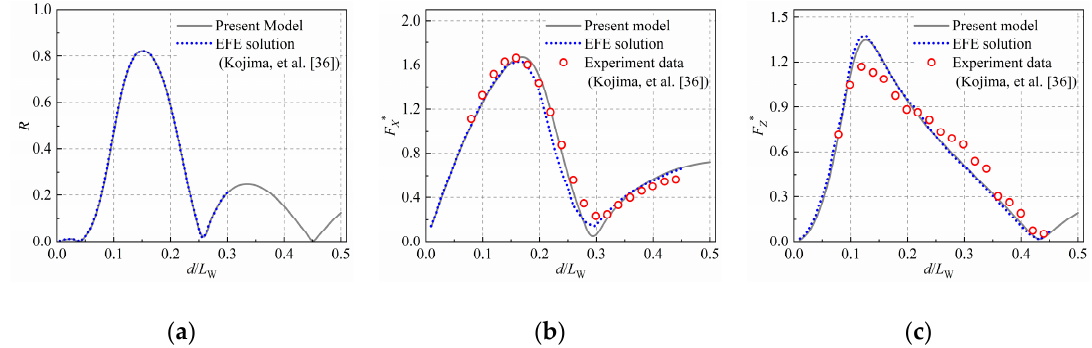
Figure 3. Comparison of ( a ) reflection and ( b , c ) wave loads on submerged plate between present study and result of Kojima, et al. [36].